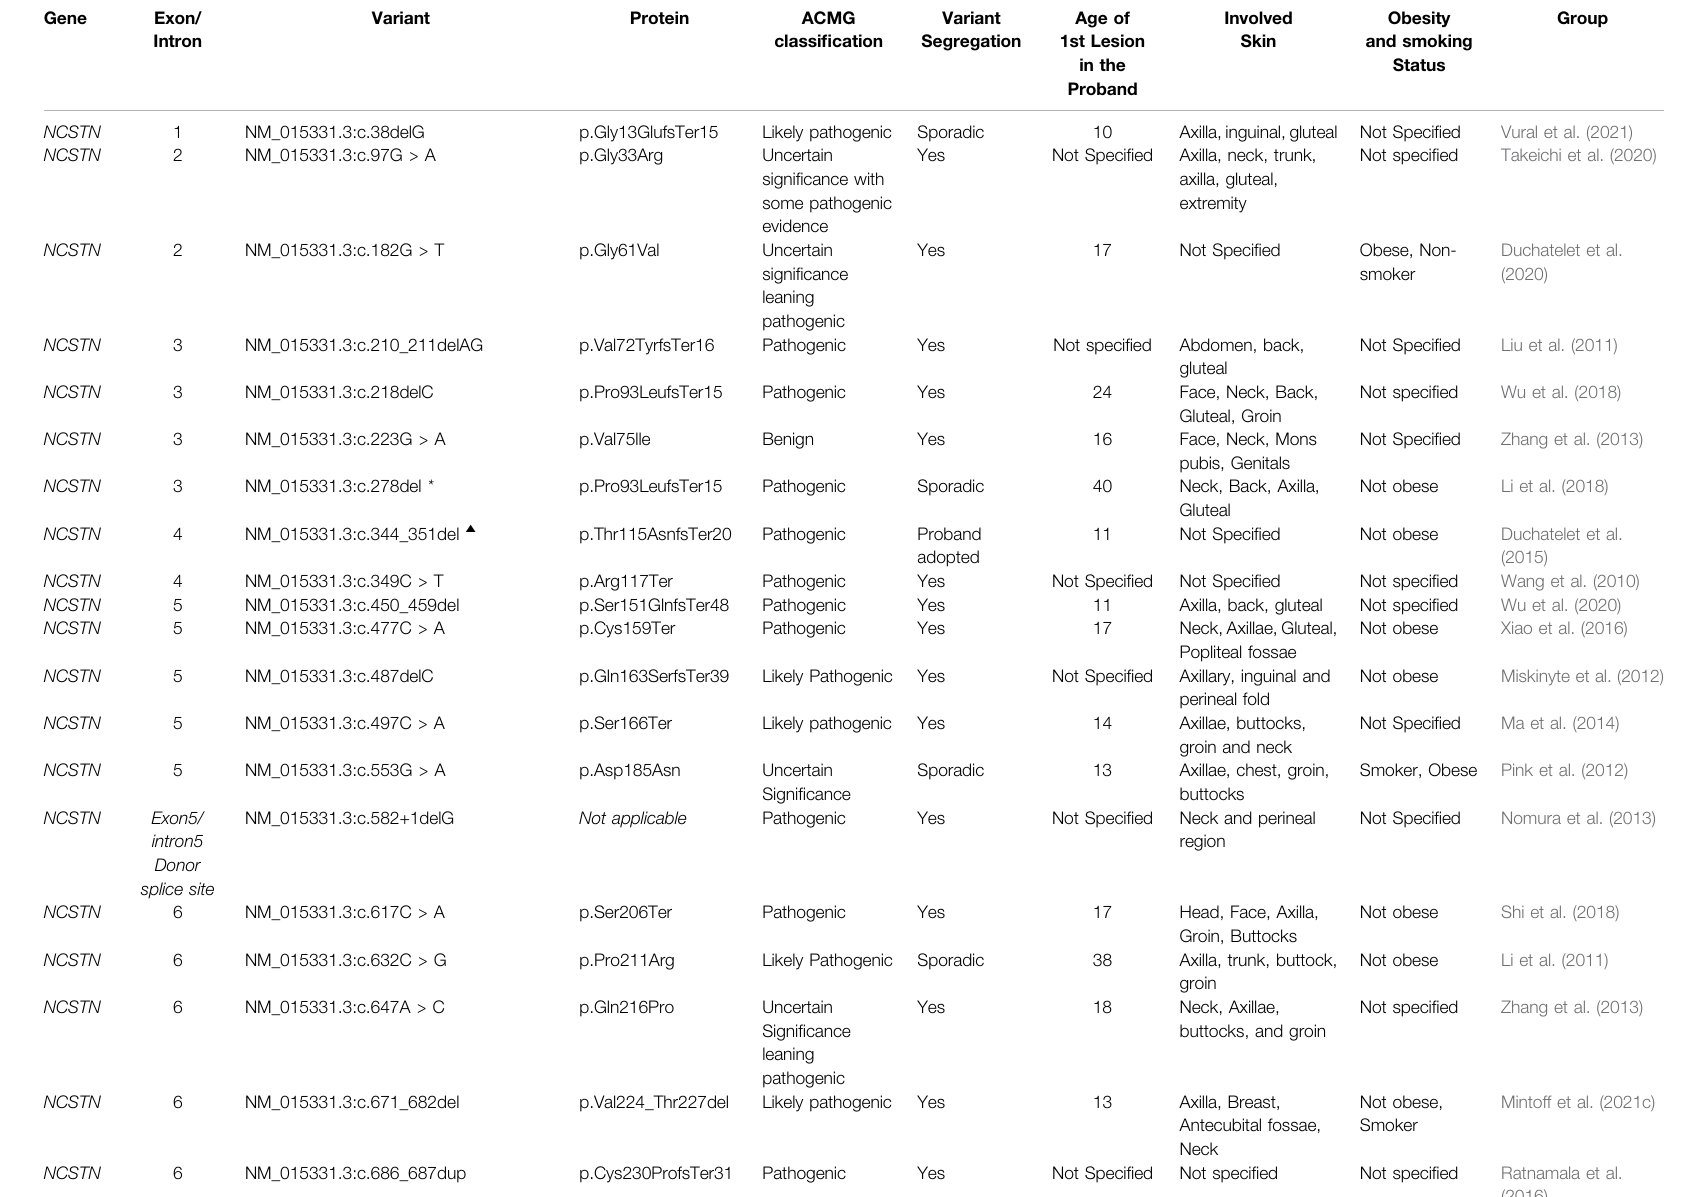
(cid:129) PAPASH $ PPHSF + HS-DDD